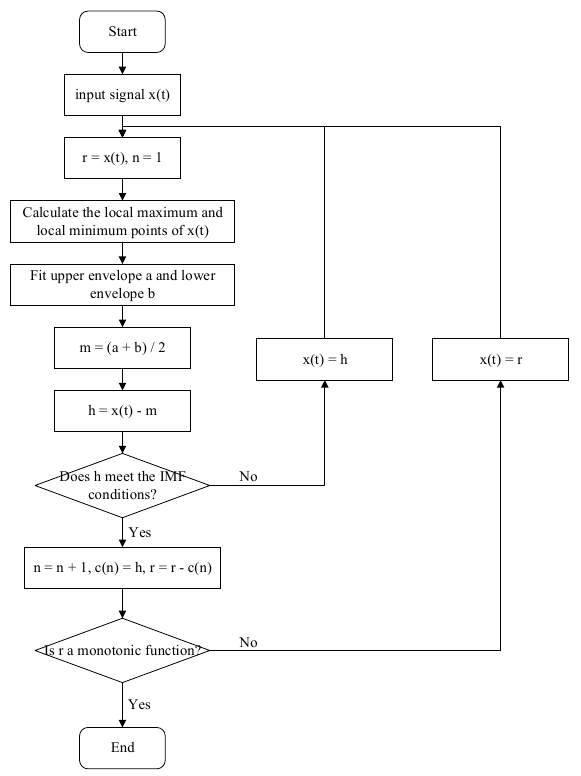
Figure 3. The process of empirical mode decomposition.